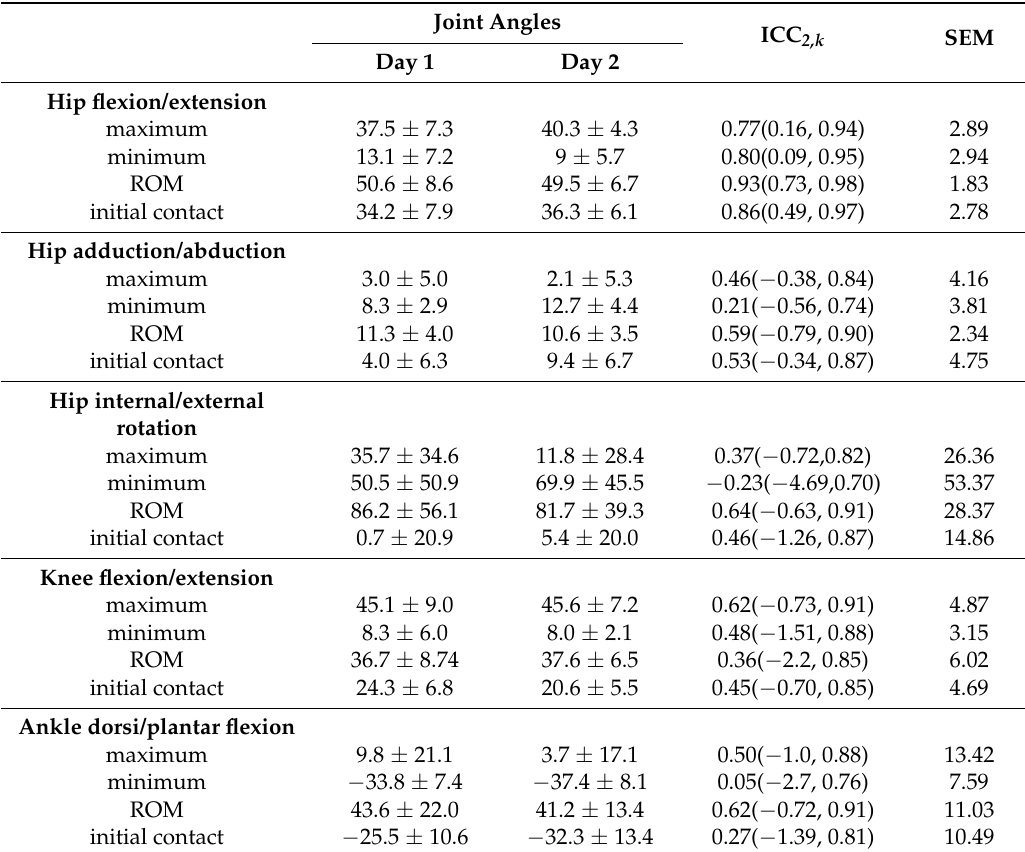
Table 6. Mean (+SD) values for each parameter testing in day 1 and day 2. Reliability (intra-class correlation coefficients (ICC 2,k ) with 95% confidence intervals for agreement and standard error of measurement